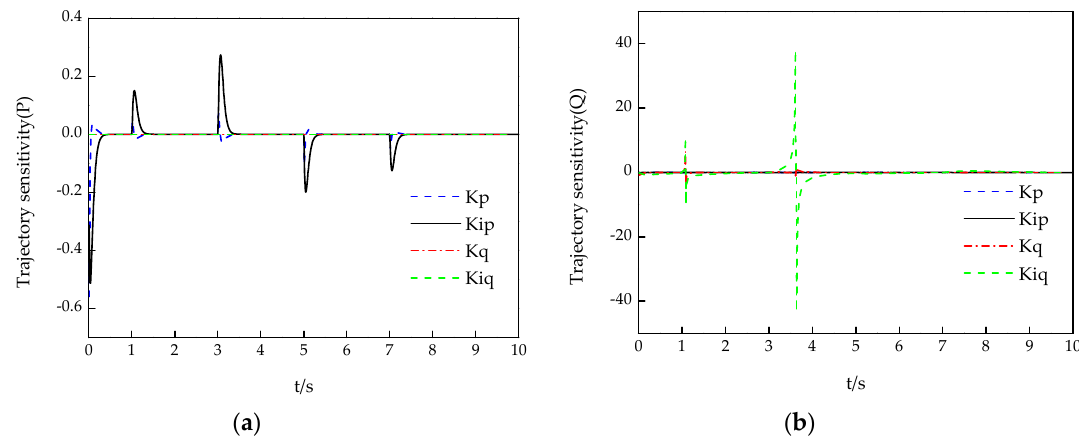
Figure 3. ( a ) Sensitivity curve of active power of the parameter to be identified; ( b ) sensitivity curve of reactive power of the parameter to be identified. Trajectory sensitivity in the case of short-circuit fault.